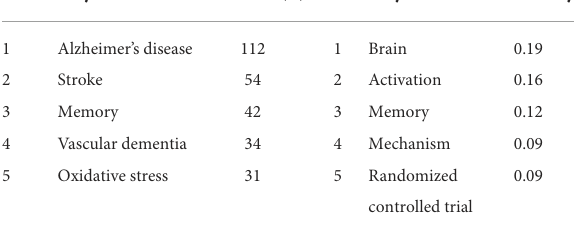
TABLE 6 Top five keywords related to acupuncture treatment of cognitive